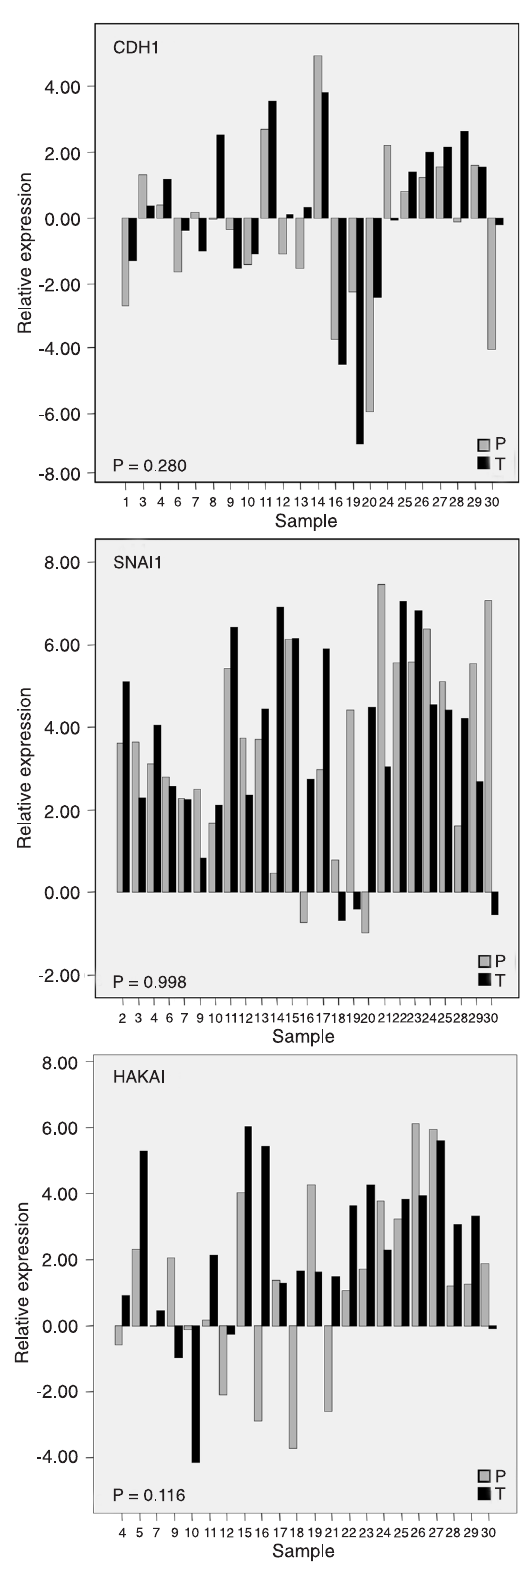
Figure 2. CDH1, SNAI1, and HAKAI mRNA expression in epithelial cells isolated from the primary tumor site and its normal adjacent tis- sue. Epithelial cells from tumor (T) and peritumoral (P) sites were recovered separately by immunomagnetic positive selection. Relative expression was calculated as described in Methods and is shown on the y-axis as its natural logarithm (Ln) value. Individual expression values are shown and sample identification appears on the x-axis. Not all 30 specimens had the expression values for the three target genes evaluated in paired samples. Since data followed a normal dis- tribution, the paired t -test was employed and P values appear inside the